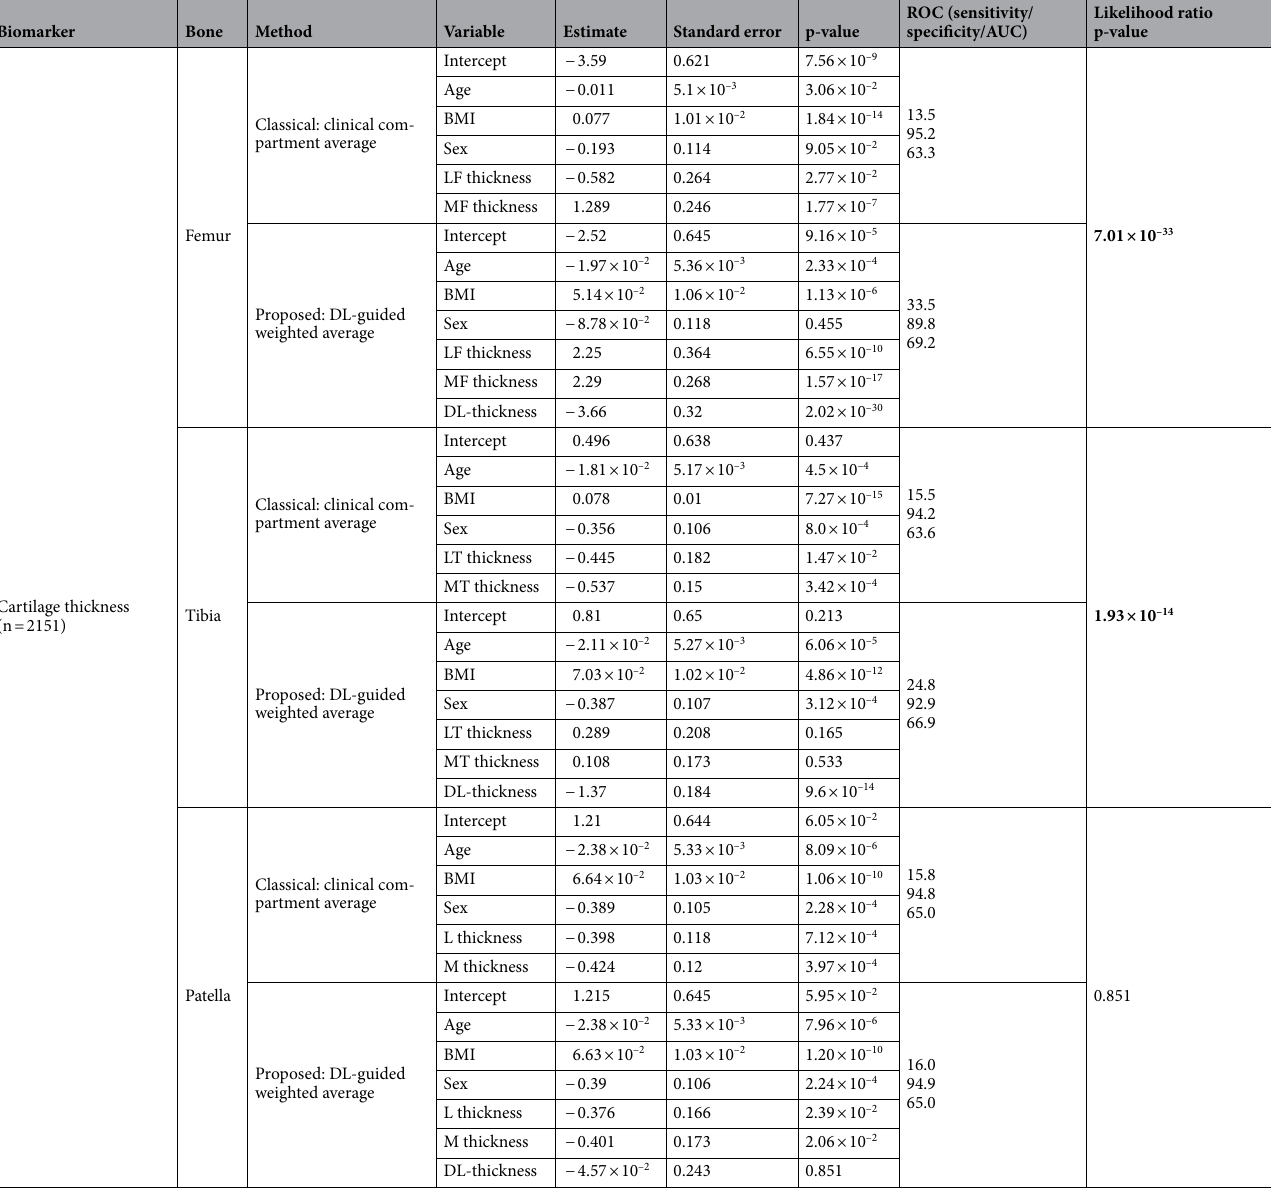
Table 3. Logistic regression results for the cartilage thickness biomarker for all bones. The demographic factors, such as age, BMI, and sex, are included to the logistic regression models as well as the different cartilage thickness averaging methods. The results are shown for the two definitions for OA imaging biomarkers, clinical compartment average and DL-guided weighted average for the femur, tibia, and patella. LF Lateral Femur, MF Medial Femur, MT Medial Tibia, LT Lateral Tibia, M Medial, L